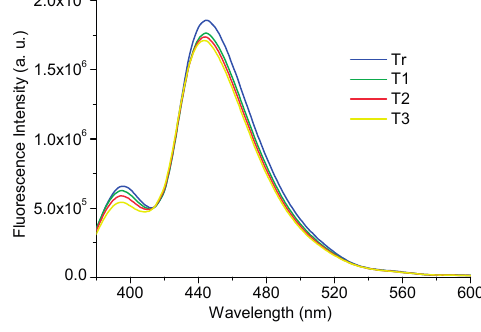
Figure 8. Fluorescence spectra ( λ exc = 350 nm) at different temperatures for phantom 2, described in Table